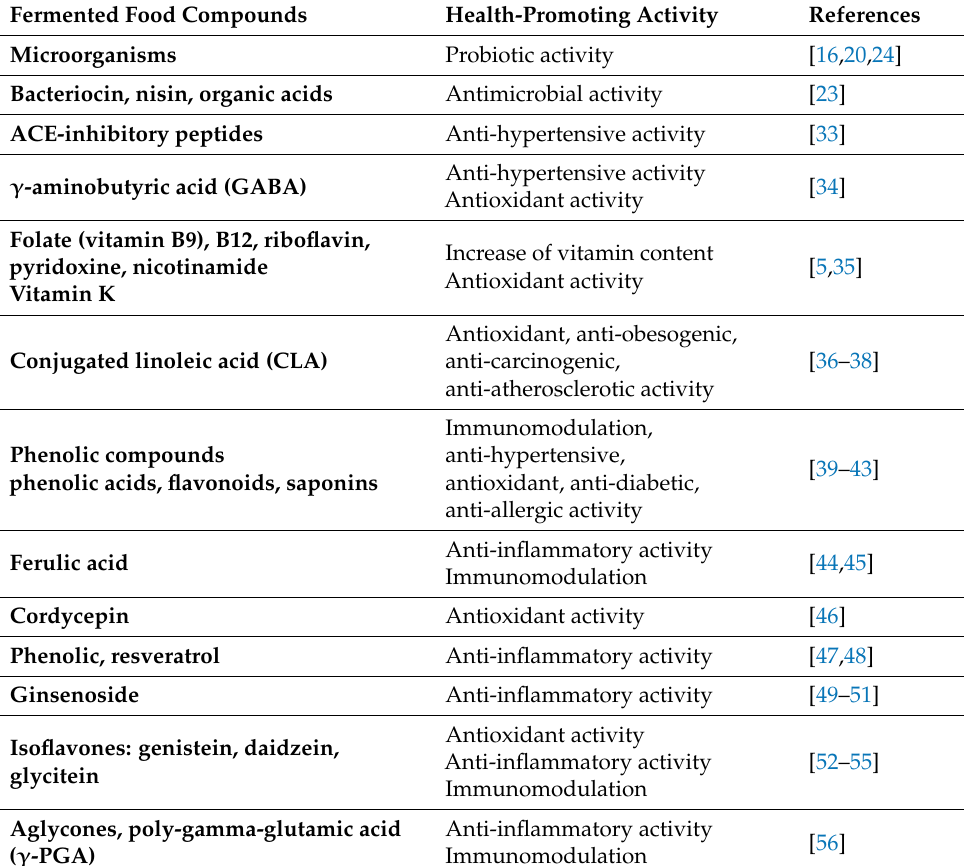
Table 2. Health-promoting components in fermented